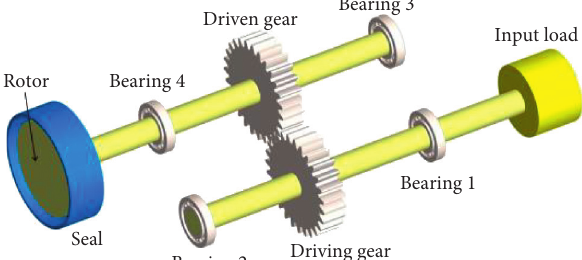
Figure 1: Gear-rotor-seal-bearing (GRSB) system.